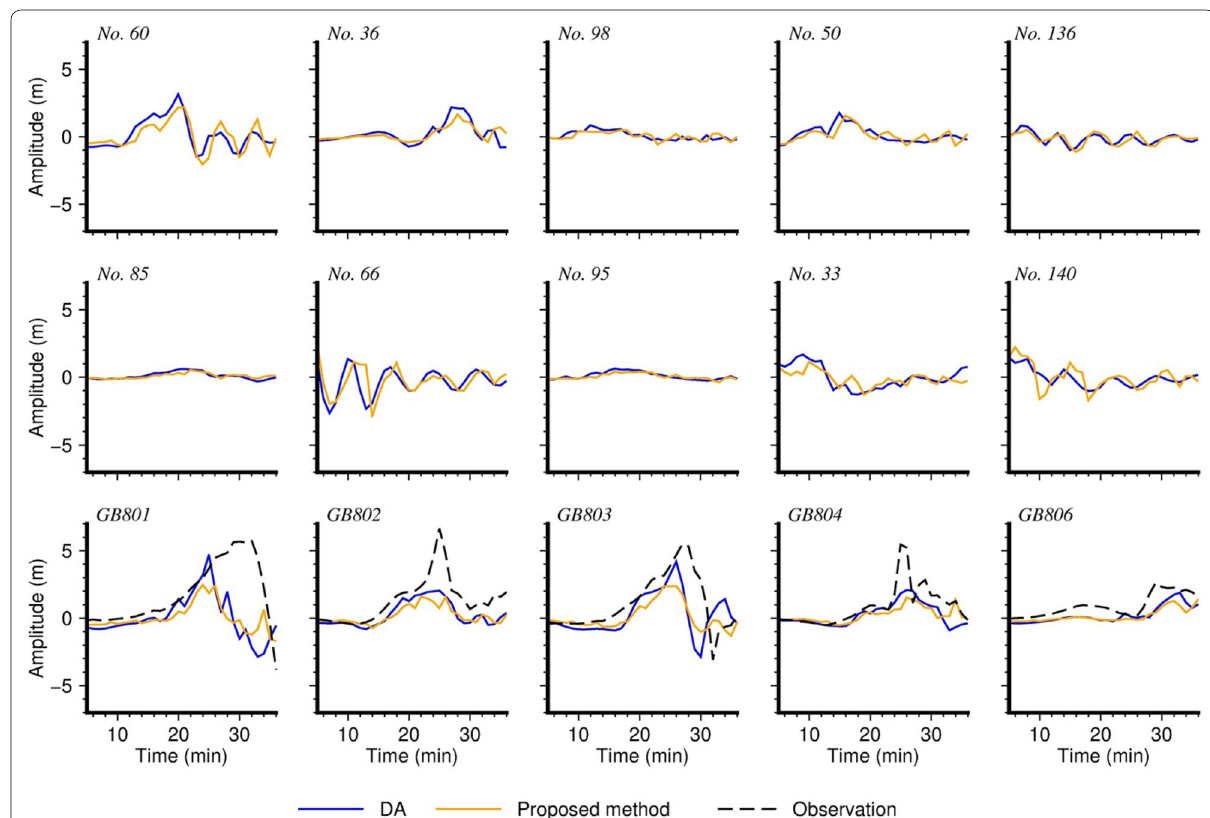
Fig. 10 Comparisons of the waveforms between the proposed method, DA and observations at GPS buoys and ten randomly selected stations for the 2011 Tohoku tsunami. The location of the selected stations is shown in Fig.